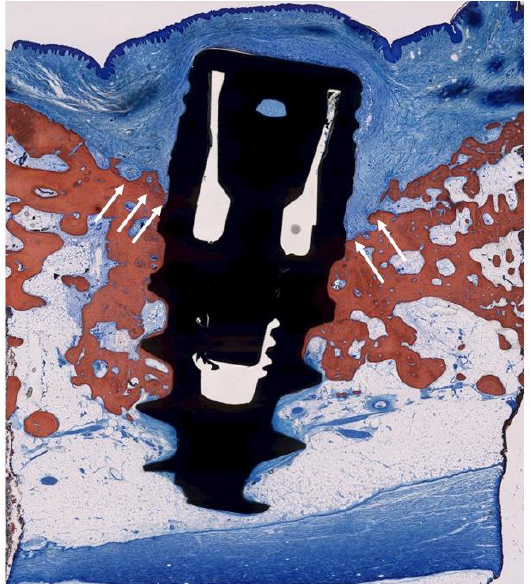
Figure 7. Histologic evaluation of healing after CC (TiUnite ® surface). The arrows indicate the bony crest before treatment. A small amount of new bone-to-implant contact was achieved. No re-osseointegration could be achieved on major parts of the implant surface.